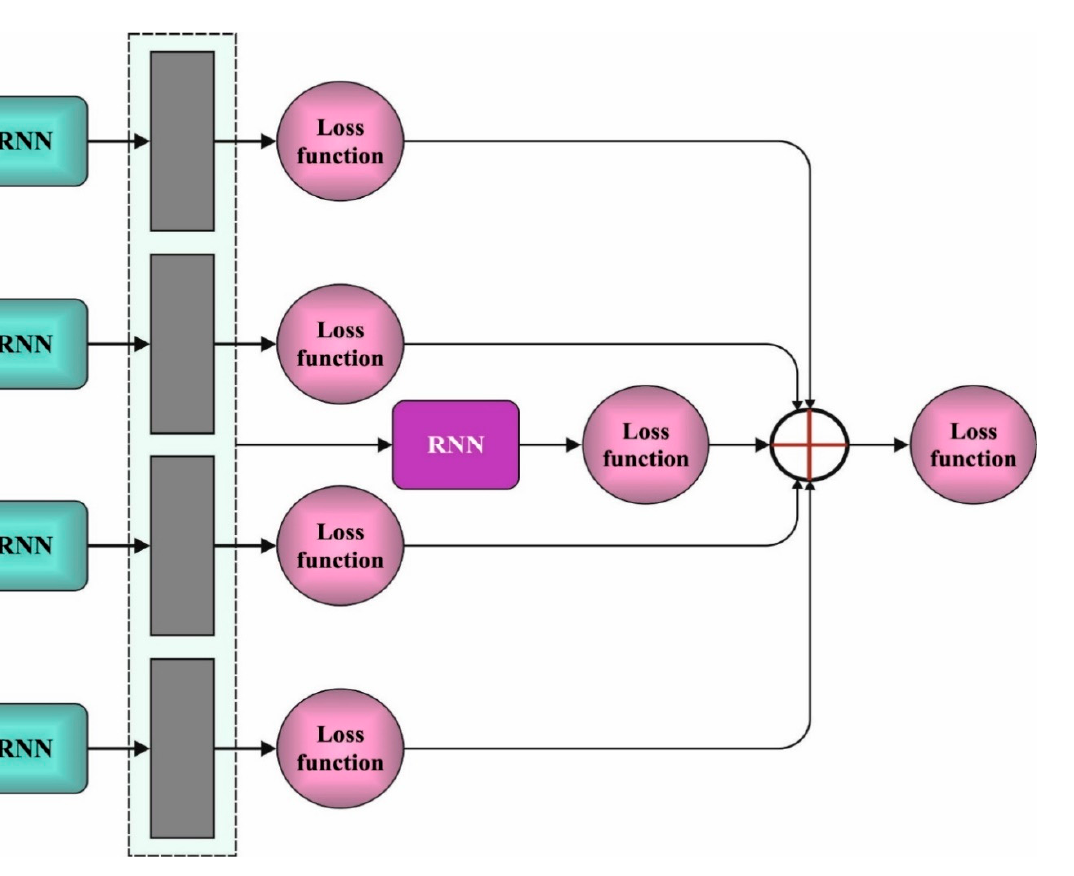
Figure 2. CRNN structure.